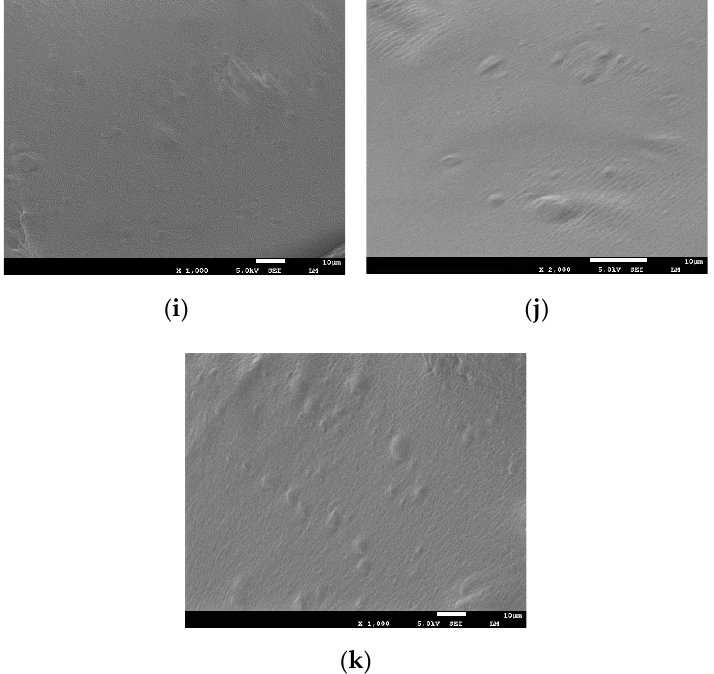
Figure 14. SEM graph of ( a ) R with EDS analysis, ( b ) R, ( c , d ) P, ( e ) 1% R-modified asphalt, ( f ) 7% R- modified asphalt, ( g ) 5% P-modified asphalt, ( h ) 15% P-modified asphalt, ( i ) (1% R + 5% P)-modified asphalt, ( j ) (7% R + 10% P)-modified asphalt, and ( k ) (7% R + 15% P)-modified asphalt.